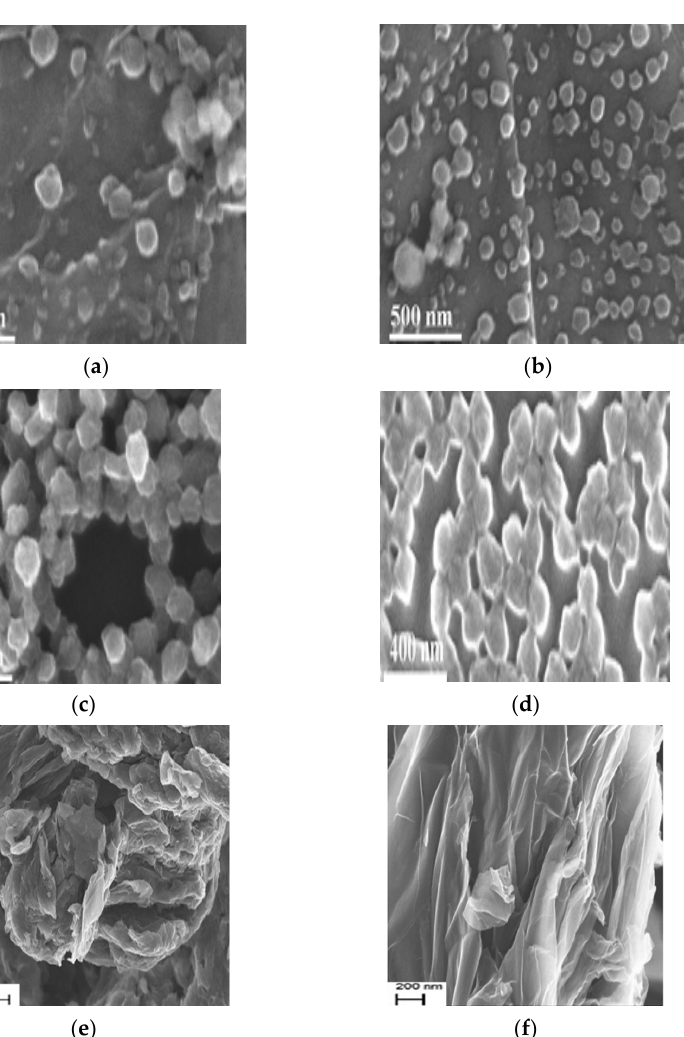
Figure 1. TEM image of ( a ) HPAN-PRGO; ( b ) PAN-PRGO; ( c ) HPAN; ( d ) PAN; ( e ) GO; ( f ) GO- NH 2 ; and ( g ) the particle size distribution of HPAN-PRGO nanocomposite.